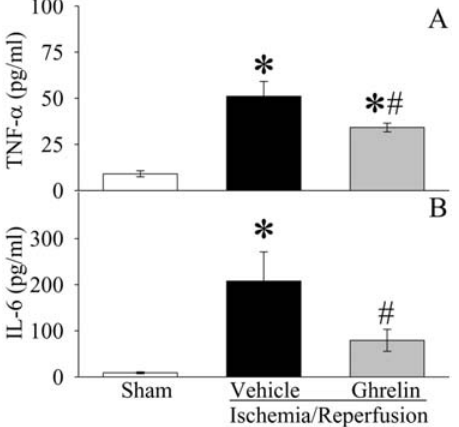
Figure 2. Alterations in serum levels of TNF- a (A) and IL-6 (B) in sham-operated animals (Sham) and ischemia/reperfusion ani- mals treated with normal saline (Vehicle) or ghrelin (Ghrelin) at 1.5 h after the completion of treatment (i.e., 2 h after reperfusion). Data are presented as means 6 SE (n=6/group) and compared by one-way analysis of variance (ANOVA) and Student- Newman-Keuls test: * P , 0.05 versus Sham group; # P , 0.05 versus I/ R + Vehicle group.